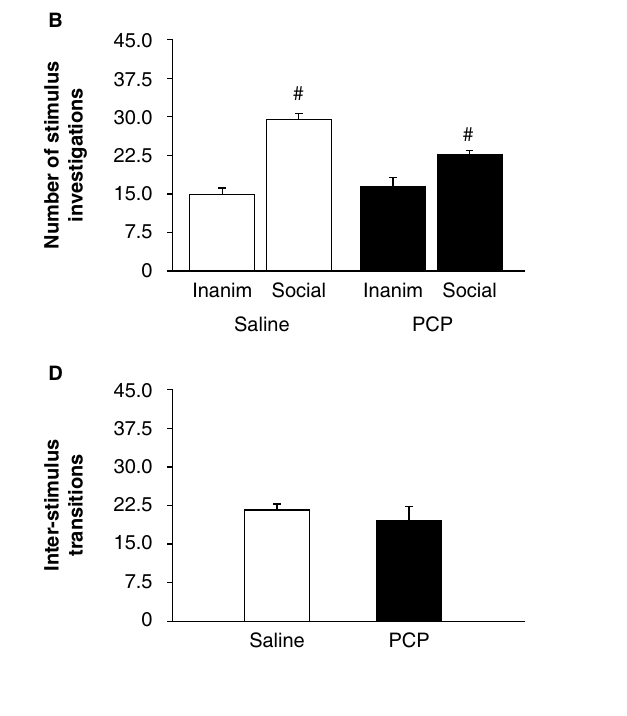
FIGURE 1 | Effects of subchronic PCP treatment on sociability in C57BL/6J mice. In contrast to saline-treated controls, mice subchronically treated with PCP did not spend signifi cantly more time investigating the social stimulus than the inanimate stimulus (A) . Mice subchronically treated with either PCP or saline made signifi cantly more investigations of the social stimulus than the inanimate